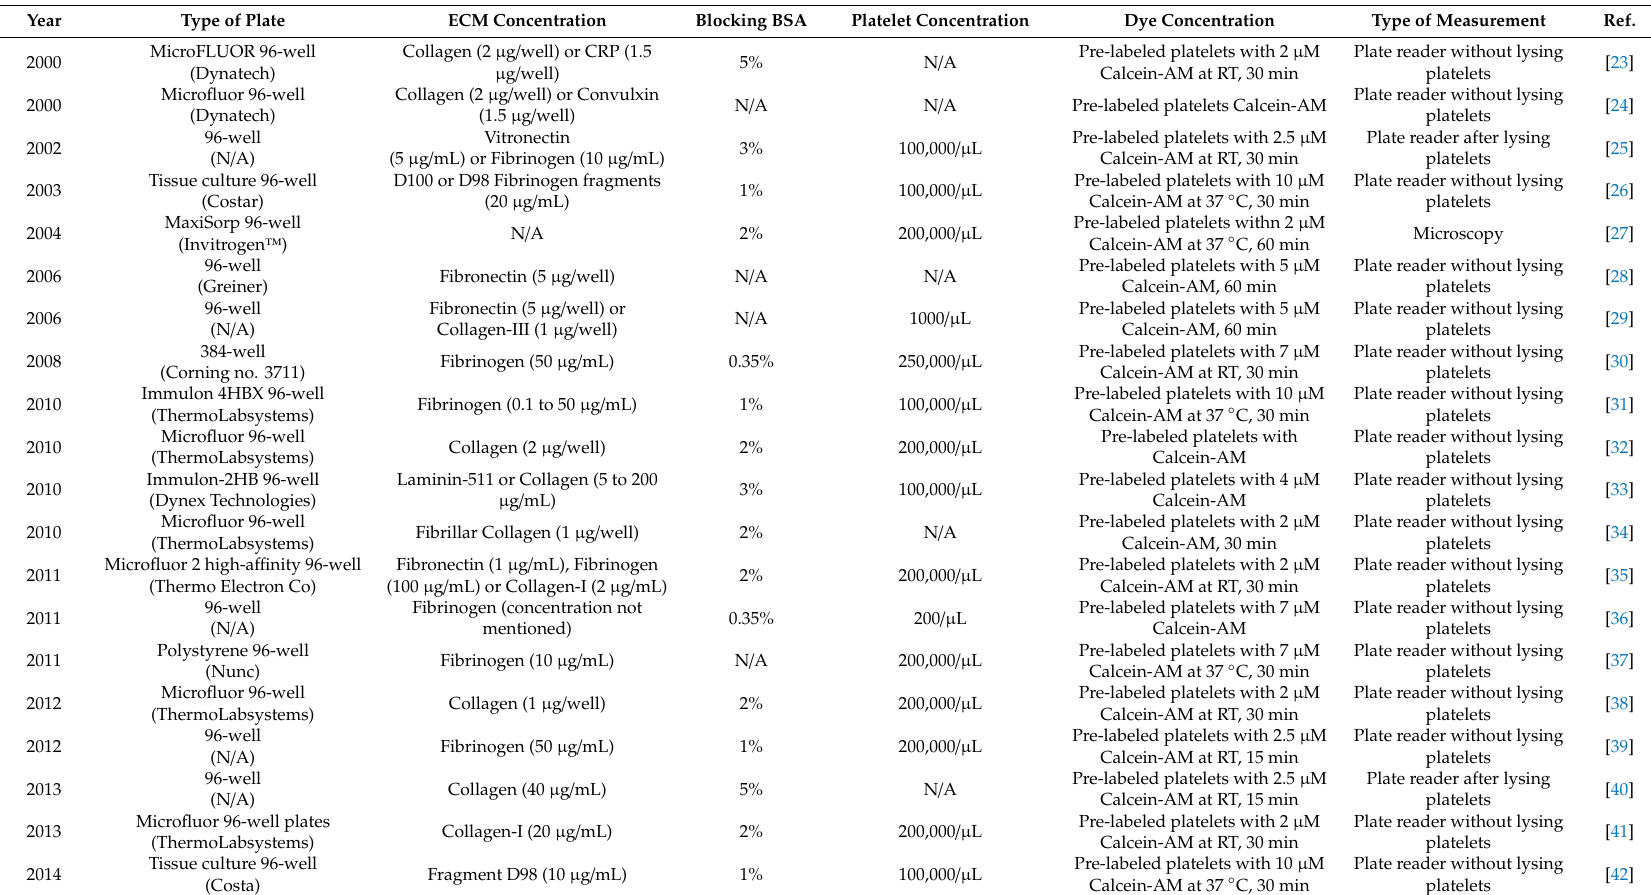
Table 1. Previous studies using Calcein-AM to measure platelet